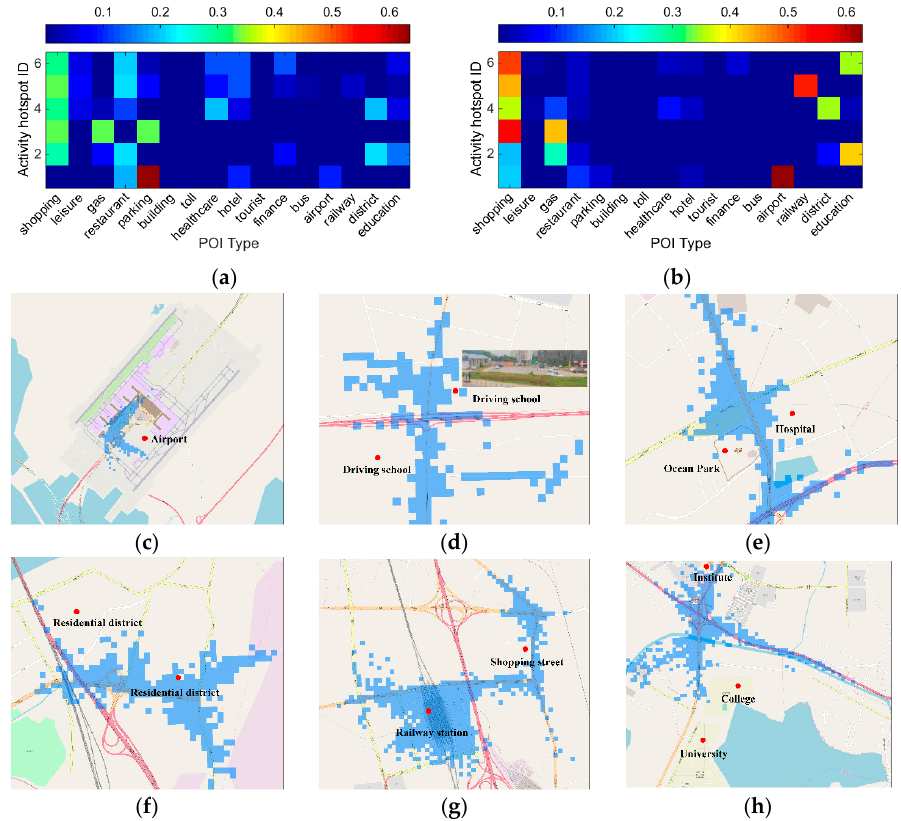
Figure 7. Urban functionality of the activity hotspots and their validations on OpenStreetMap (available at: www.openstreetmap.org): ( a ) prior probability of functionality distribution; ( b ) inferred probability of functionality distribution; ( c ) activity hotspot 1, providing aviation services with an international airport; ( d ) activity hotspot 2, providing educational services with driving schools; ( e ) activity hotspot 3, providing recreation and healthcare services with an ocean park and an infectious disease hospital, which cannot be inferred by our model; ( f ) activity hotspot 4, serving as a residential area with many shopping sites; ( g ) activity hotspot 5, providing railway services with a train station; ( h ) activity hotspot 6, serving as an educational area with several institutions or